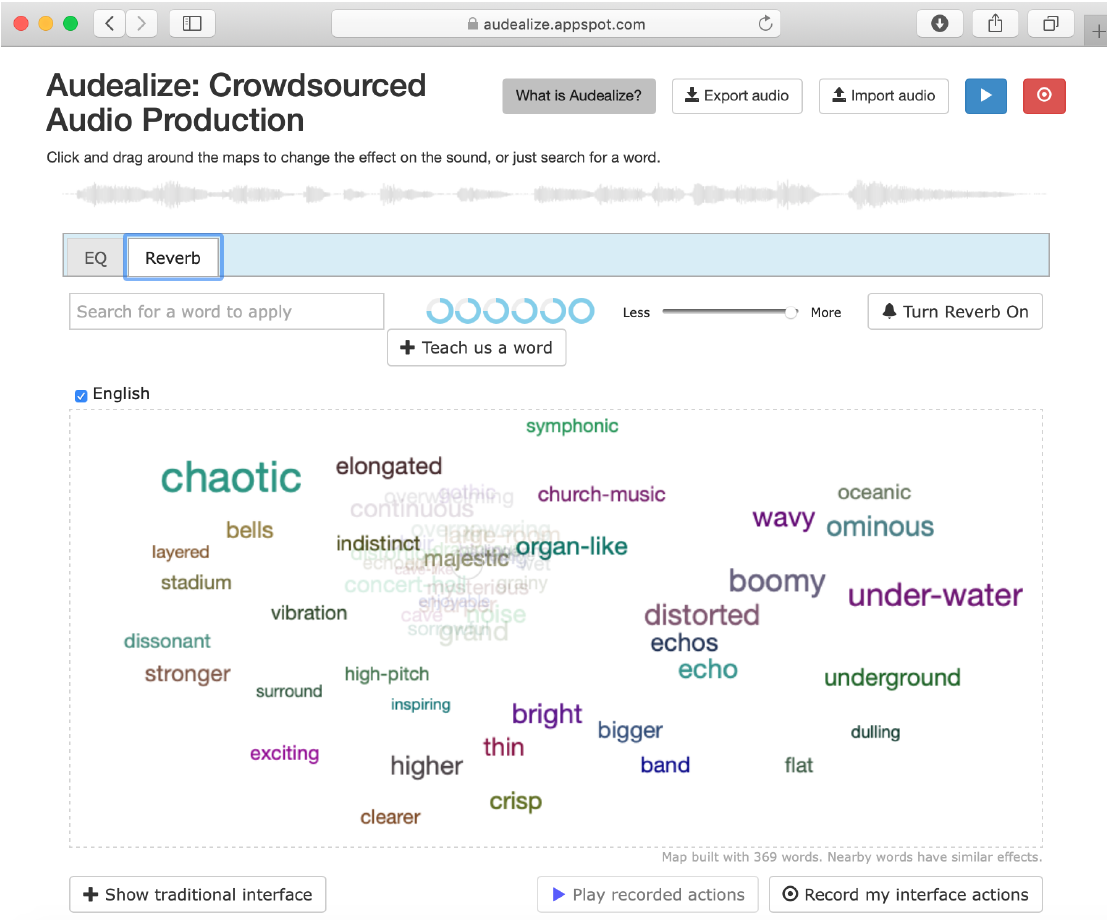
Figure 6. Audealize is a new way of looking at audio production tools. Instead of the traditional complex interfaces consisting of knobs with hard-to-understand labels, Audealize provides a semantic interface. Simply describe the type of sound you’re looking for in the search boxes, or click and drag around the maps to find new effects. Screen capture created by the